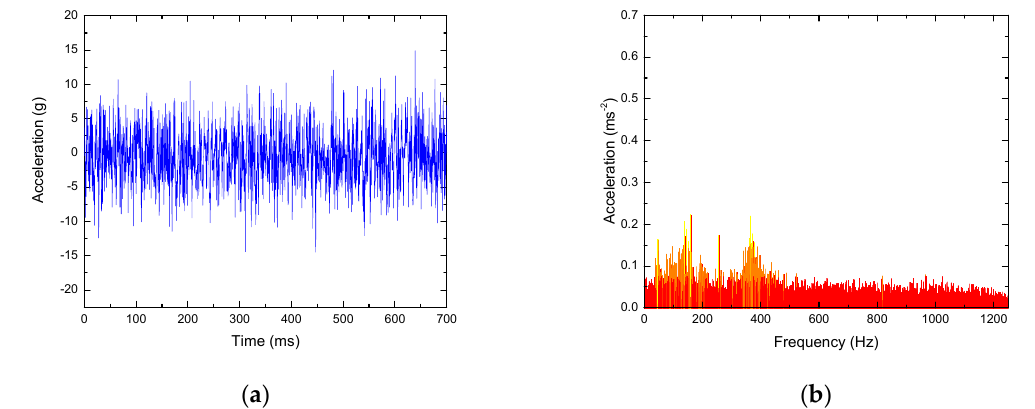
Figure 13. Analysis of a normal rail vibration signal. ( a ) Waveform; ( b ) frequency spectrum.